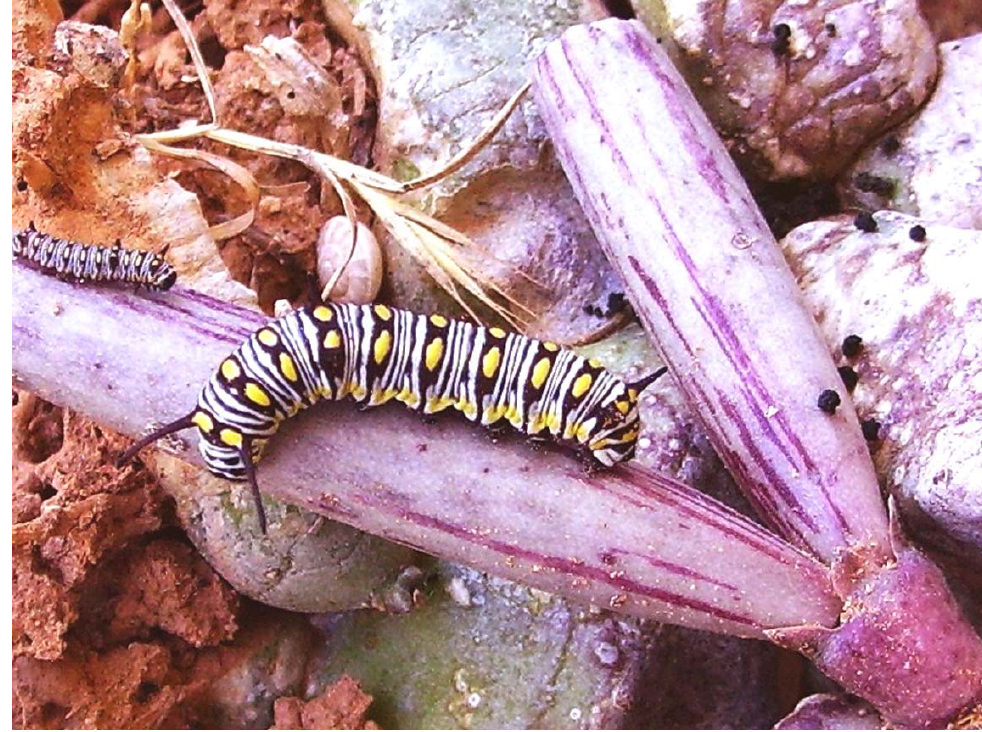
Figure 2. Larvae of D. chrysippus feeding on fruits of C. europaea in Lampedusa Island (Photo by P.